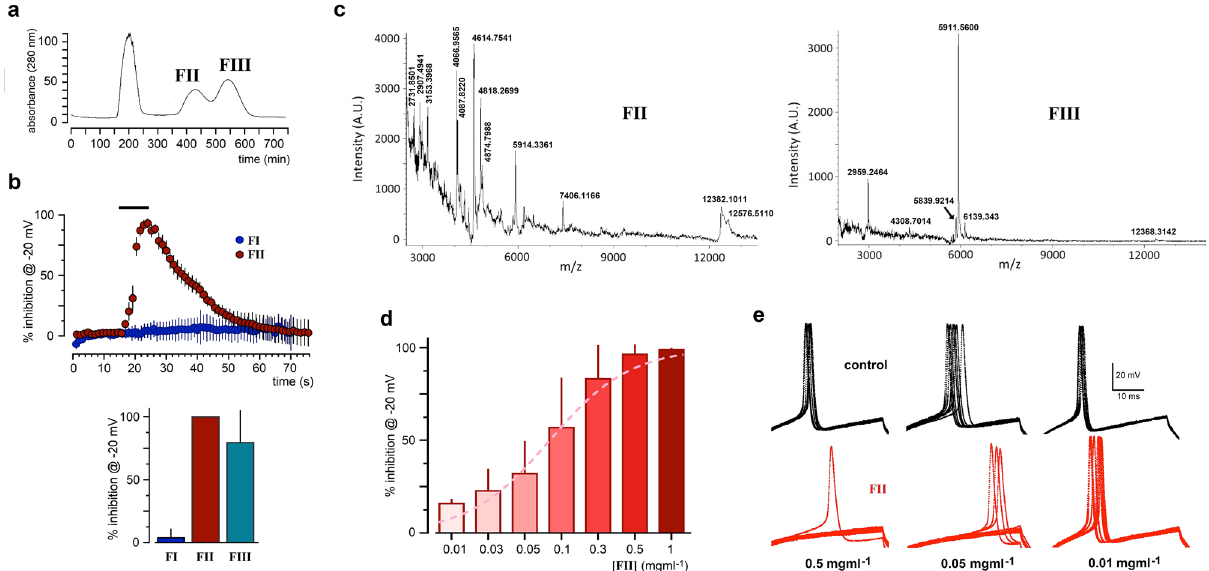
Figure 5. AE partial separation by Sephadex G-50 M chromatography, mass spectrometry, fraction dose- respond, and effect on the action potential. ( a ) Fractions obtained from AE gel filtration chromatography. Sephadex G-50 M column (90 × 8 cm) was equilibrated with PBS. Absorbance was monitored at 280 nm and fractions were collected at a flow rate of 300 μl min −1 . Three absorbance peaks were detected and the corresponding fractions (FI, FII, and FIII) were collected and tested for effect on neuronal I Nav monitored at − 20 mV (6–14 neurons in each case, held at − 100 mV and depolarized every 750 s for 20 ms). ( b ) The graph shows I Nav inhibition time-course produced by FII (1 mg ml −1 ; 11 neurons), while FI did not produce a significant effect (4 neurons; mean ± S.D.), the column graph resumes the inhibition produced by each fraction (1 mg ml −1 ). ( c ) MALDI-TOF–MS spectrum obtained from the FII and FIII fractions obtained from AE gel filtration chromatography, the numbers indicated the mass for the main signals detected. In ( d ) FII was applied in distinct concentrations and a dose–response curve (in pink) was adjusted to data points indicating an EC 50 of 80 ± 16 μg ml −1 . ( e ) FII was tested on the neuronal action potential generated by depolarizing steps (35 ms, 0.75 nA) every 500 ms; three decreasing FII concentrations are illustrated. Traces in black (10 superimposed traces in each case) corresponded to control action potentials before FII superfusion, whereas red traces were obtained during FII application. 0.5 mg ml −1 potently inhibited the action potential, a concentration 10 times lower still blocked completely the action potential in few seconds, while 0.01 mg ml −1 FII was